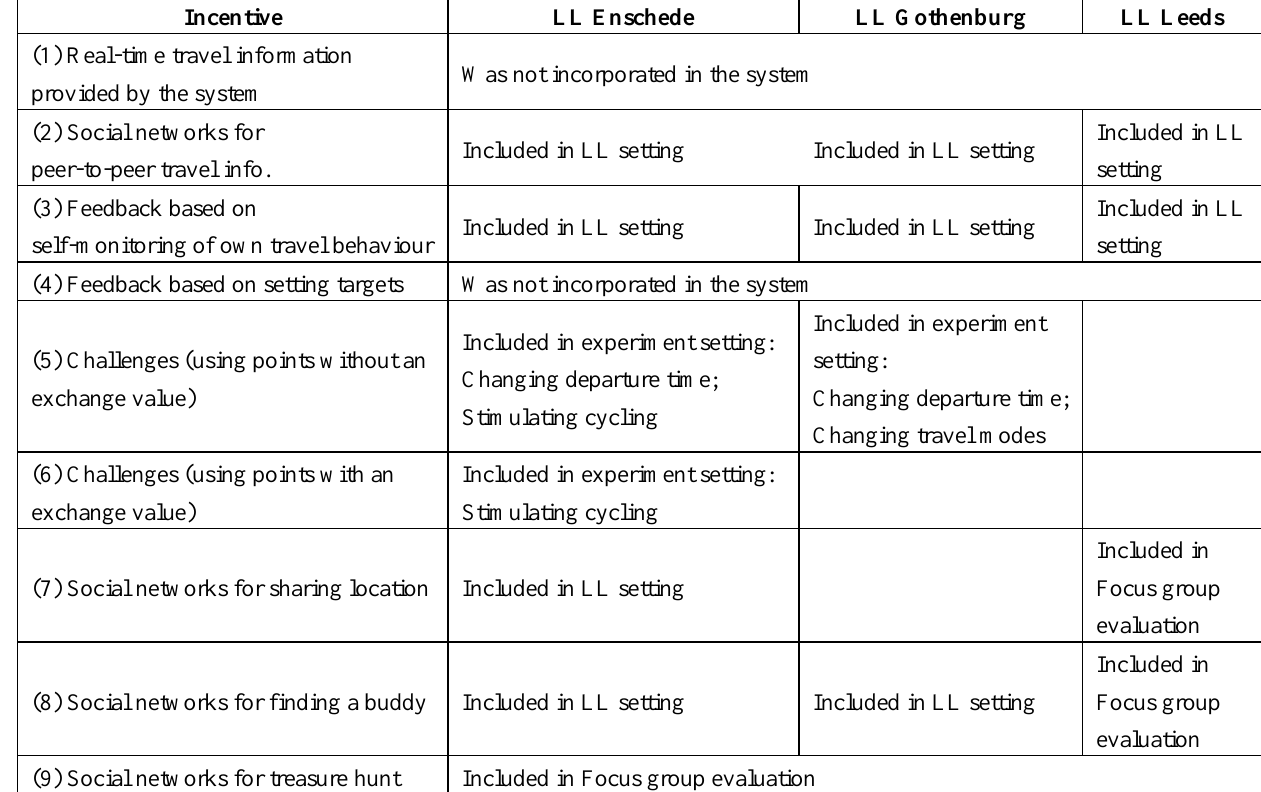
Table 5. List of proposed incentives and their implementation in the Living